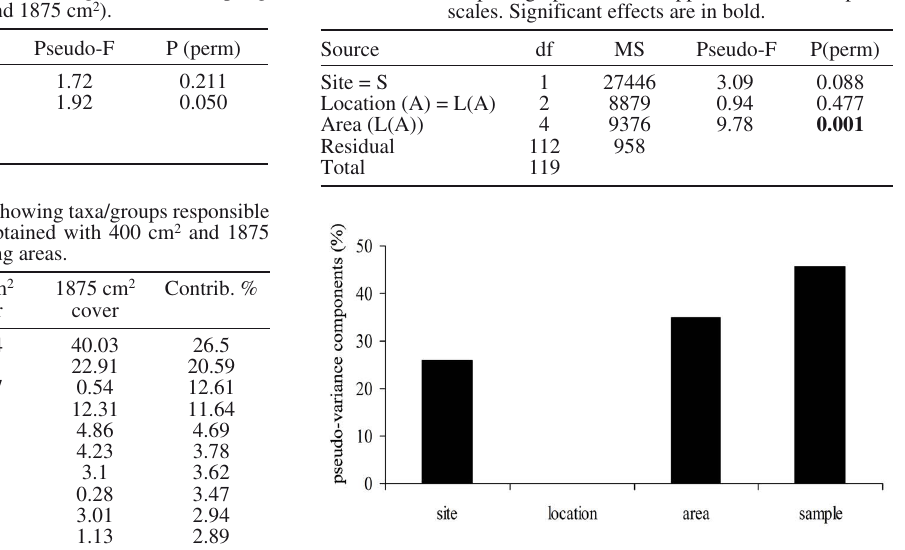
Fig . 3. – Percentage of pseudo-variance components at different spatial